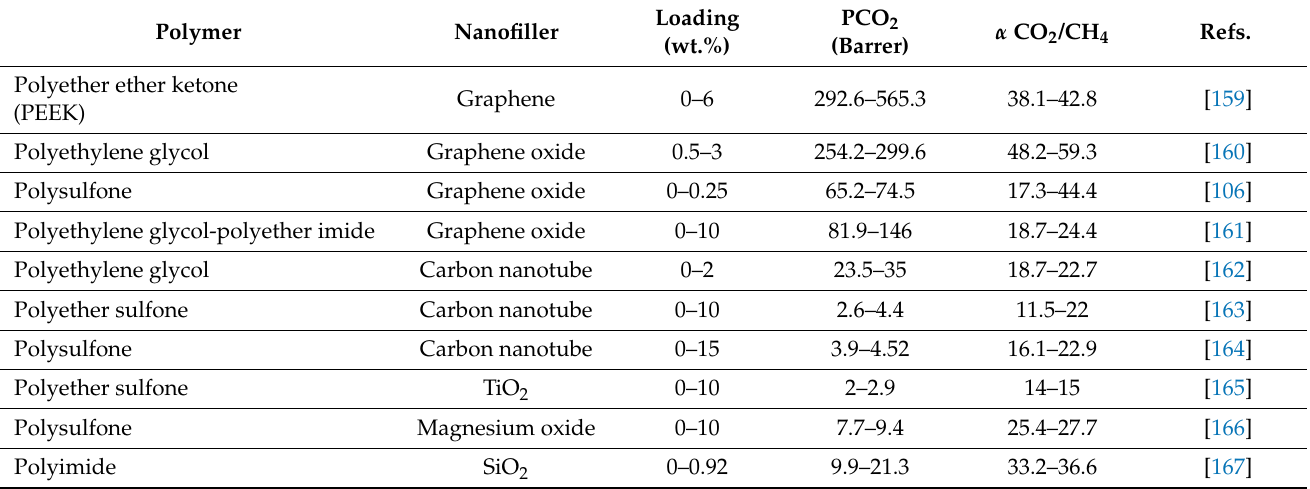
Table 4. Gas separation performance of graphene, carbon nanotube, and inorganic nanofillers based